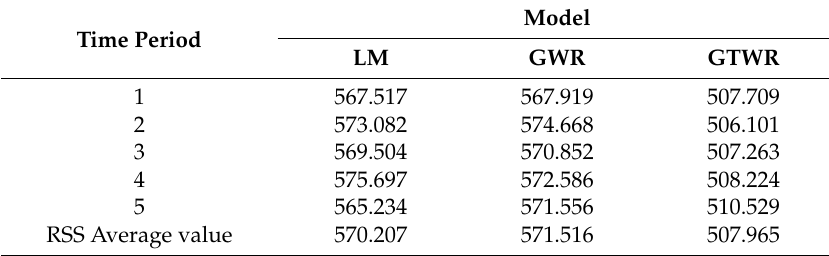
Table 6 . Statistical comparison among the three models (accounting for the RSS). Table 6. Statistical comparison among the three models (accounting for the RSS).